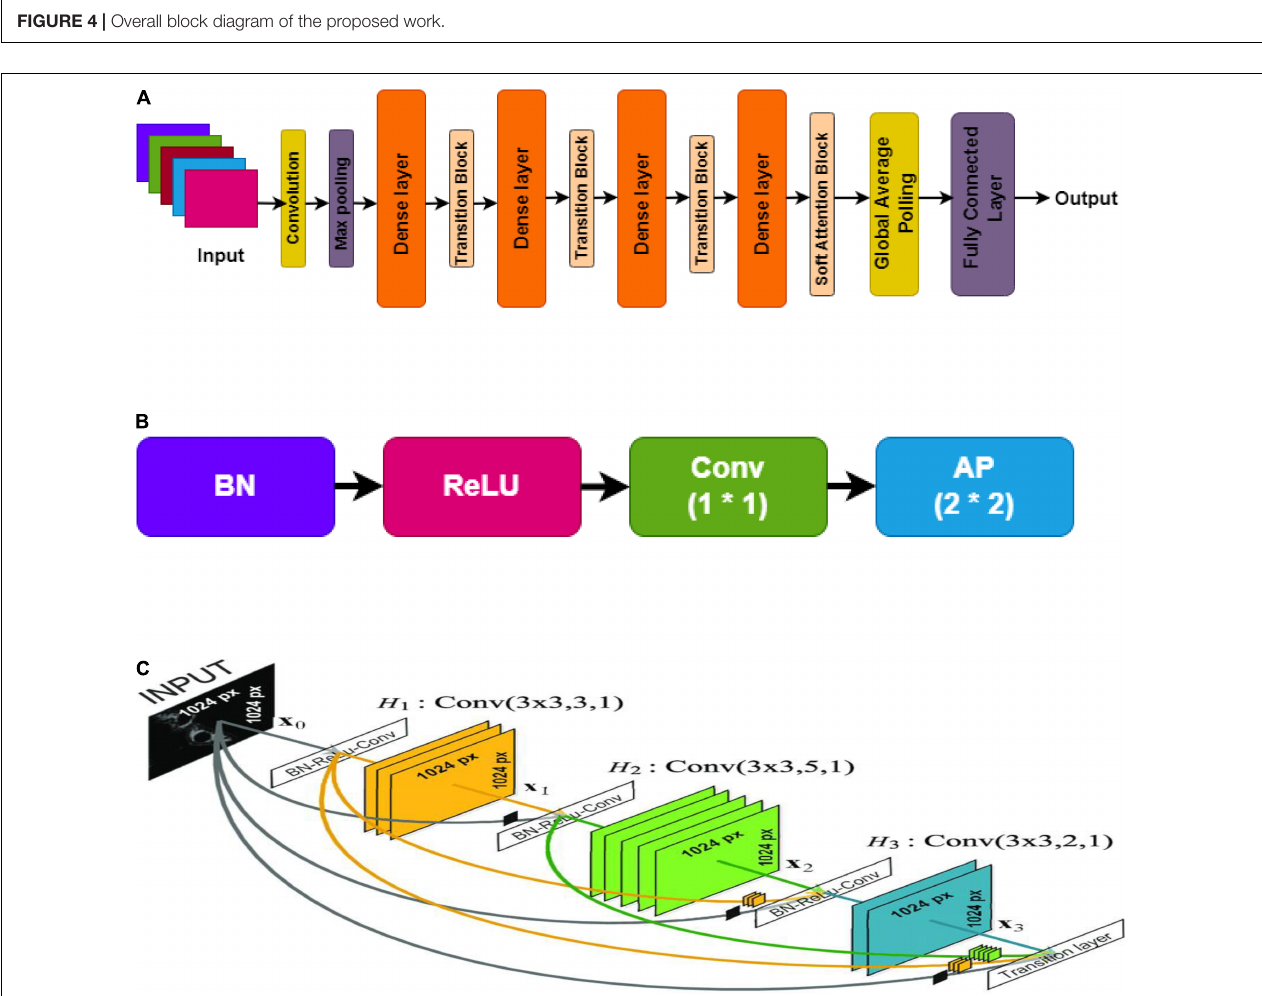
FIGURE 5 | DenseNet, (A) overall architecture; (B) transition layer; (C) dense layer.